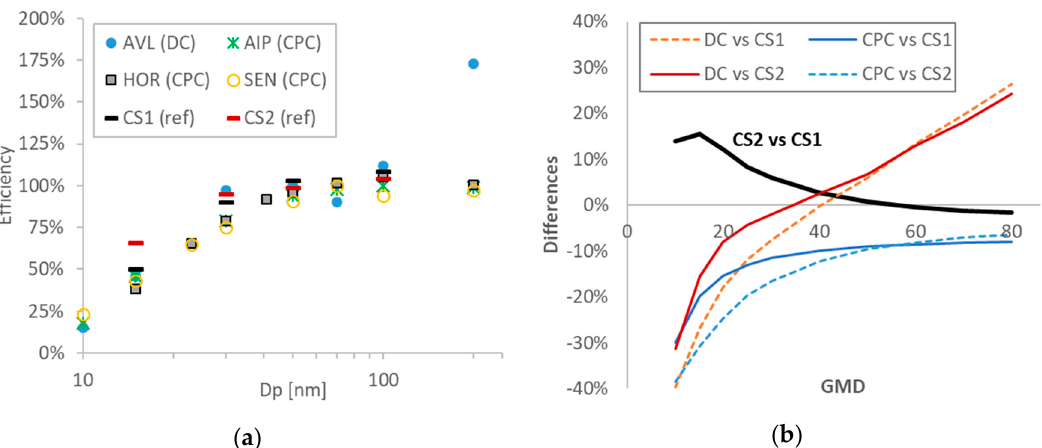
Figure 3. Comparisons of systems: ( a ) E ffi ciencies of the systems in function of the (monodisperse) mobility diameter; ( b ) calculated di ff erences among the instruments in function of the (polydisperse) geometric mean diameter (GMD). CPC = condensation particle counter; CS = catalytic stripper; DC = diffusion charger.